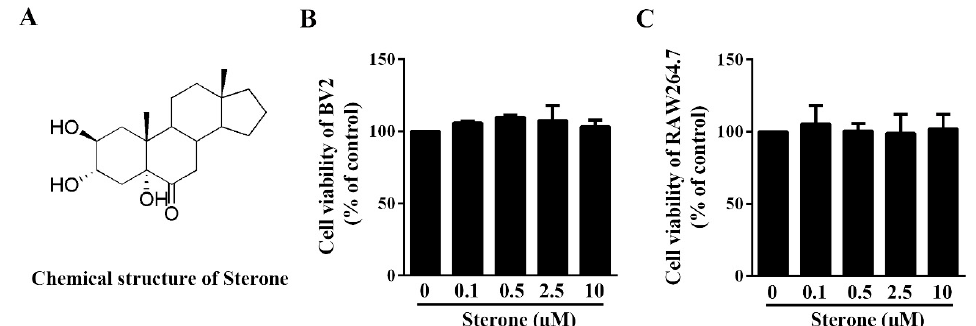
Figure 1. Sterone has no effect on viabilities of BV2 cells and RAW264.7 cells. Cells were incubated with the indicated concentrations of sterone for 24 h. The structure of sterone is shown in ( A ). Cell viabilities of BV2 cells ( B ) and RAW264.7 cells ( C ) were measured respectively MTT assay. Values are mean ± SD of three independent experiments.